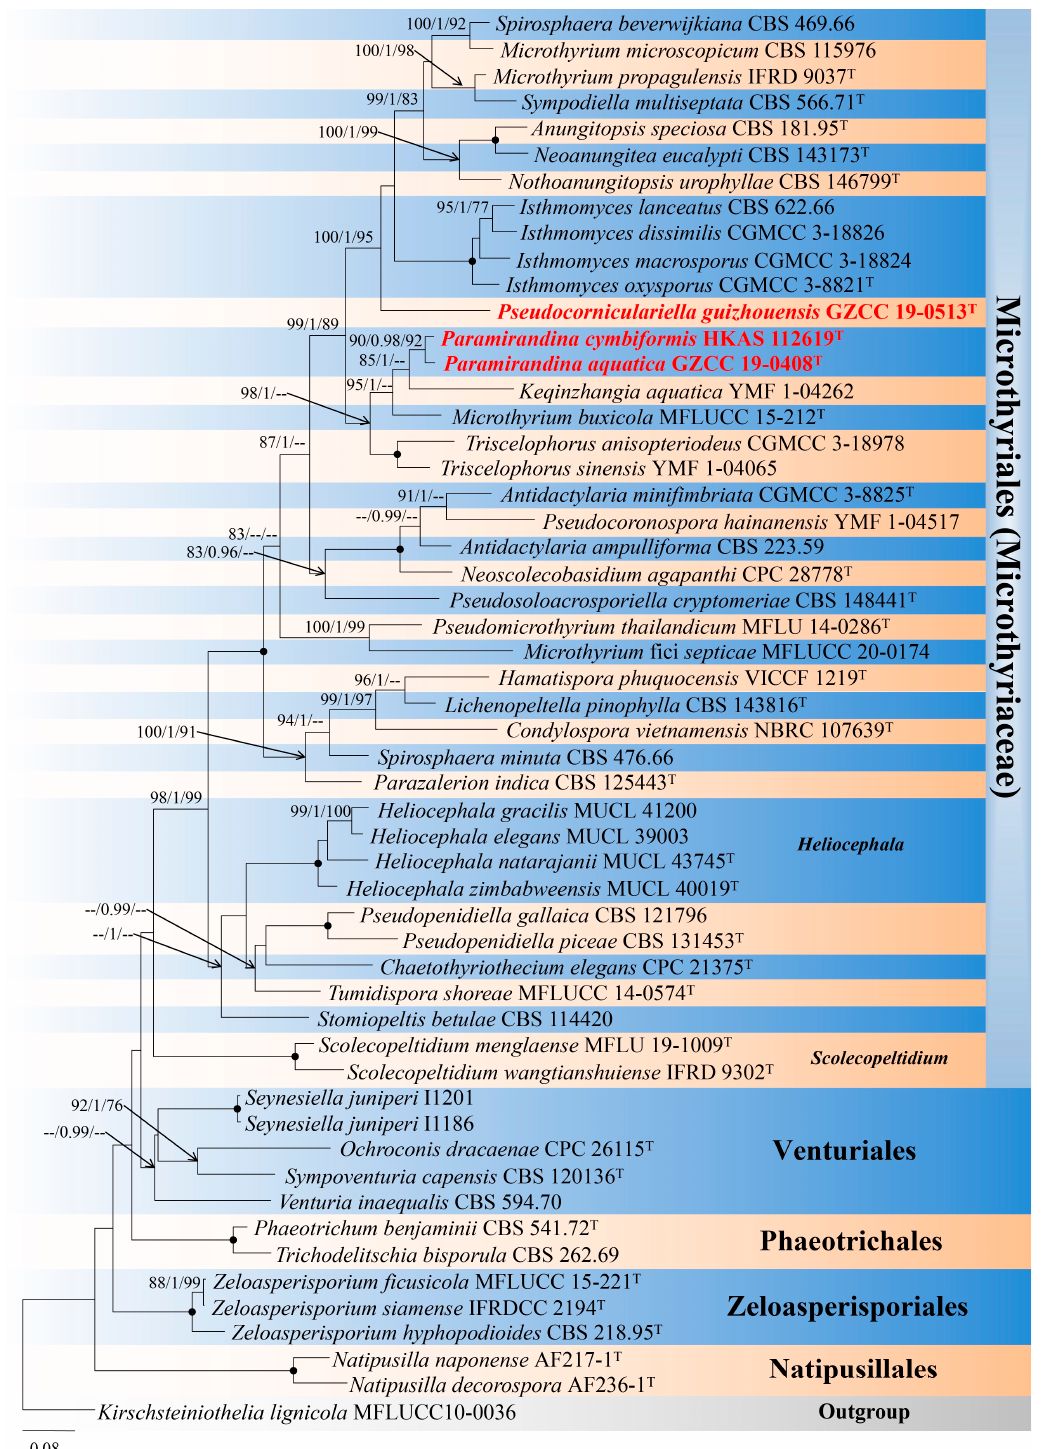
Figure 1. Maximum likelihood majority rule consensus tree for Microthyriales and related orders using ITS and LSU sequence data. Bootstrap support values for maximum likelihood (ML) and maximum parsimony (MP) greater than 75% and Bayesian posterior probabilities greater than 0.95 are indicated above branches as ML BS/PP/MP BS. The scale bar represents the expected number of changes per site. The tree is rooted with Kirschsteiniothelia lignicola (MFLUCC 10-0036). Ex-type strains are indicated with T. The new taxa are in red bold. Branches with 100% ML BS, 1.0PP and 100% MP BS were dotted with black dots. Orders are indicated as colored blocks.